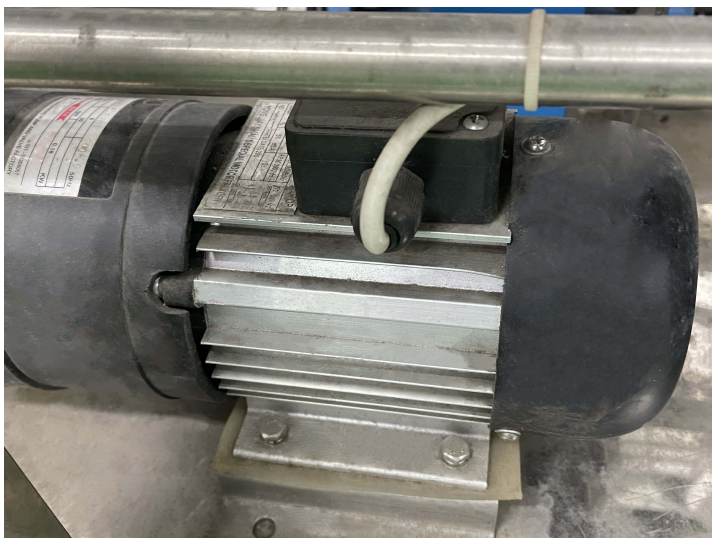
Figure 4. Glue pump